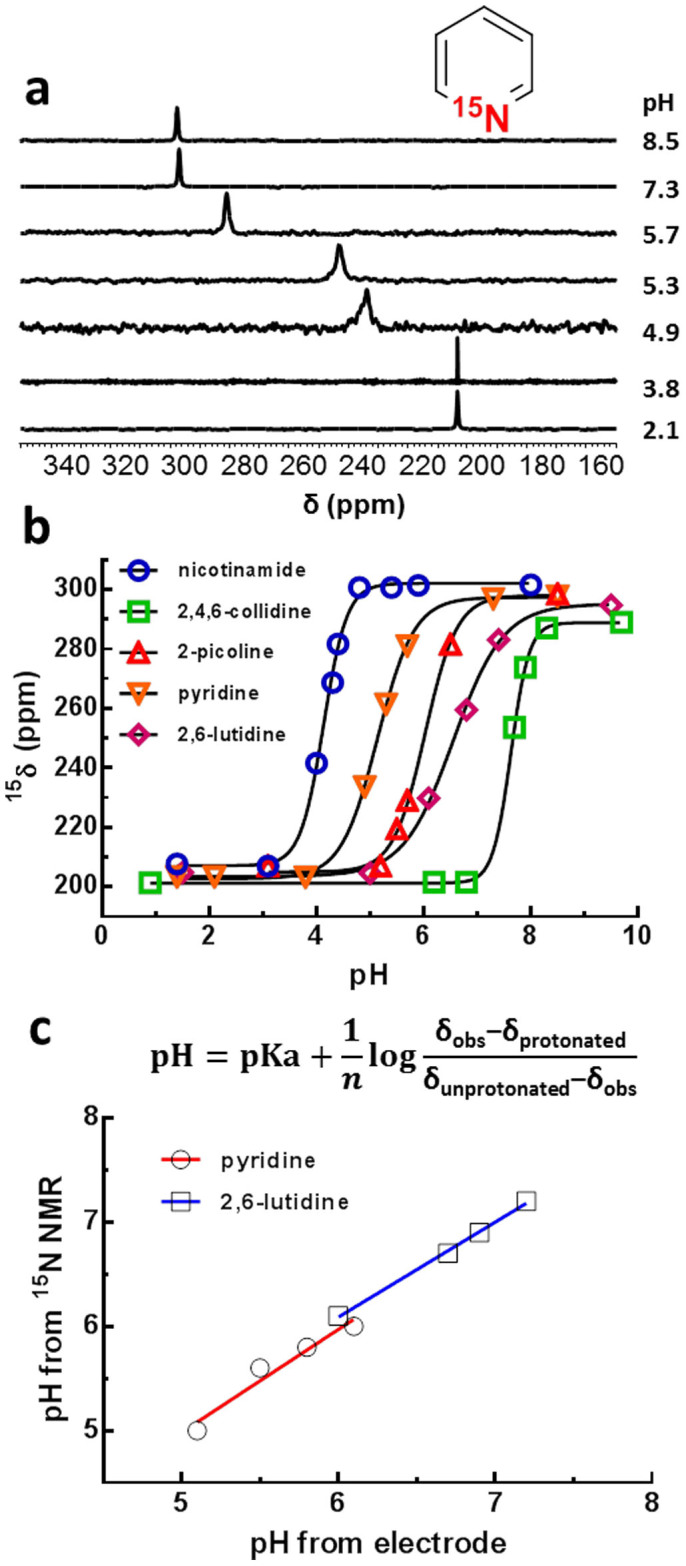
15N chemical shift versus pH for HP 15N-agents; (a) 15N-NMR spectra of hyperpolarized 15N-agents versus pH; (b) 15N-NMR titration curves of hyperpolarized 15N-agents; (c) correlation of pH calculated from the Hendersen-Hasselbalch equation (displayed above) and pH electrode.δobs is the 15N chemical shift observed from NMR spectra, δprotonated is the 15N chemical shift of fully protonated pyridine, δunprotonated is the 15N chemical shift of basic pyridine, n is the Hill coefficient.